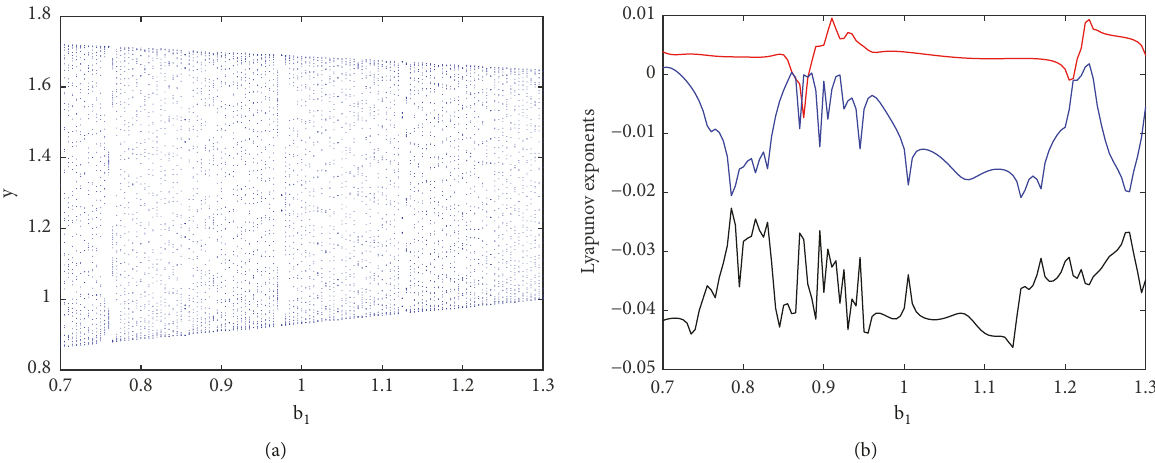
Figure 4: Bifurcation diagram and corresponding Lyapunov exponential diagram of the variable 𝑏 1 ∈ [0.7,1.3] change of system (1): (a) bifurcation diagram and (b) Lyapunov exponential diagram of corresponding (a).